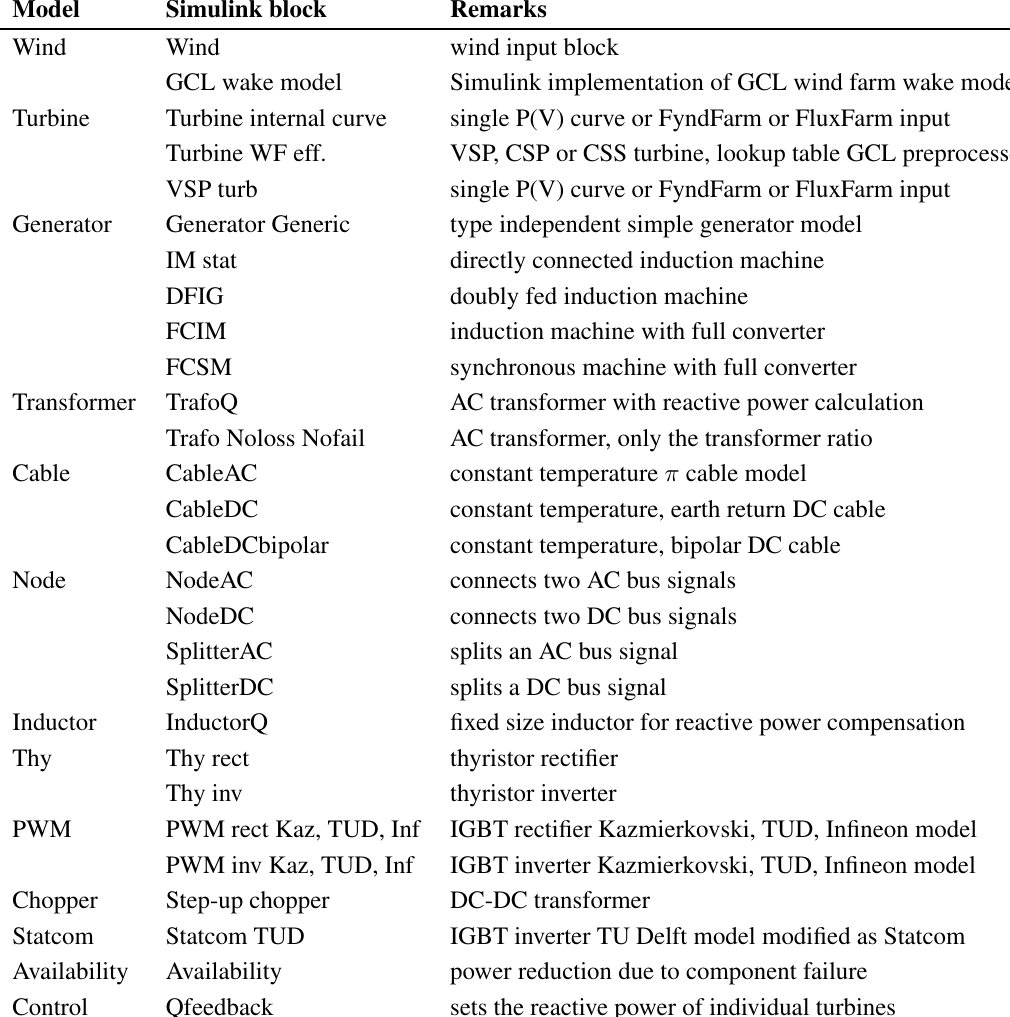
Table 2 . Overview of EeFarm II